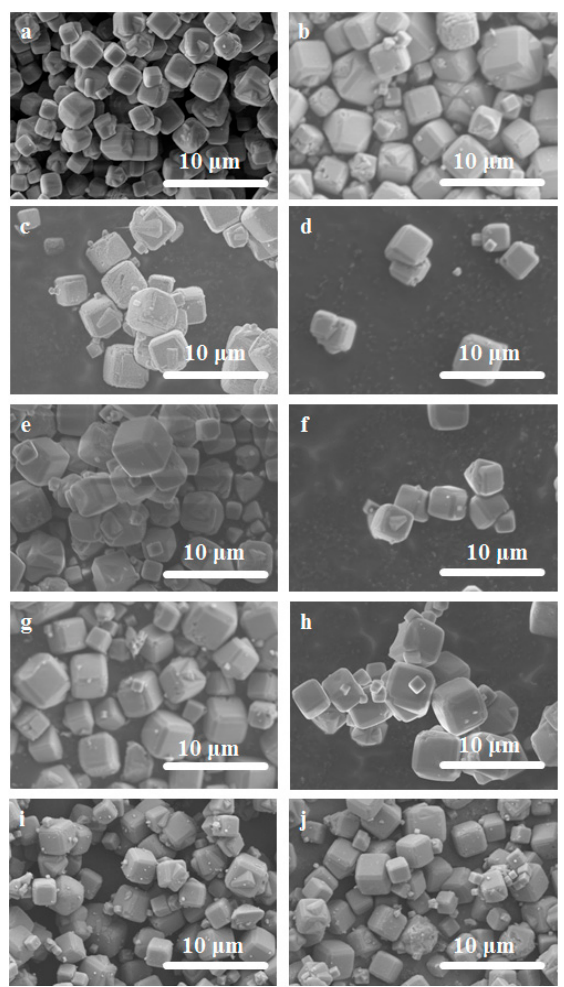
Figure 6. SEM images of NaA zeolite particles ( a ) and ion-exchanged zeolite with ( b ) KCl, ( c ) AgNO 3 , ( d ) NH 4 Cl, ( e ) LiCl, ( f ) NaCl, ( g ) CaCl 2 , ( h ) BaCl 2 , ( i ) ZnCl 2 and ( j ) MgCl 2 solution treatment.